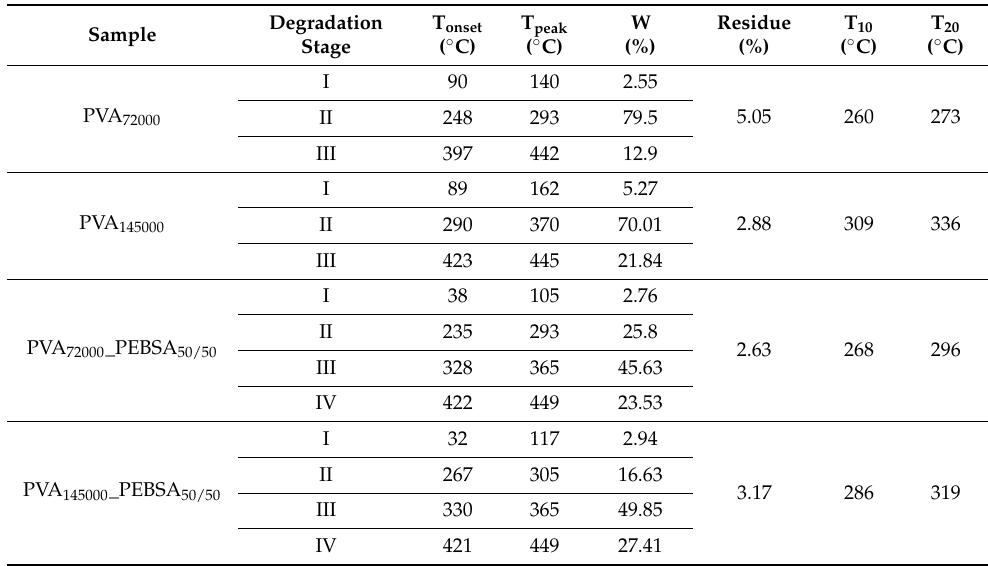
Figure 3. ( a ) The TG and DTG curves of the PVA 72000 _PEBSA 50/50 cryogel and ( b ) the TG and DTG curves of the PVA 145000 _PEBSA 50/50 cryogel. Table 2. The main thermal parameters determined for the cryogel